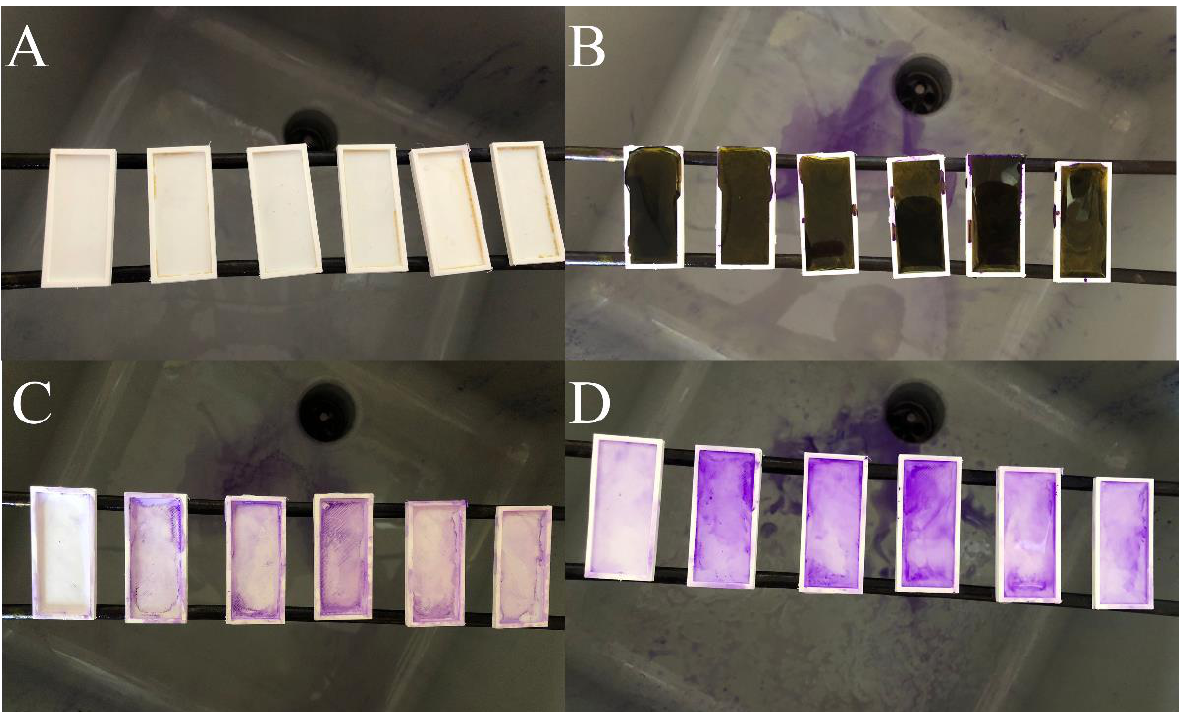
Figure 4. Modified crystal violet staining for quantitative assessment of BBF on the 3D-printed plates. (( A ) = initial aspect of the BBF after incubation. ( B ) = crystal violet staining. ( C ) = aspect of the BBF after washing the stain with water. ( D ) = discoloration using alcohol-acetone.).